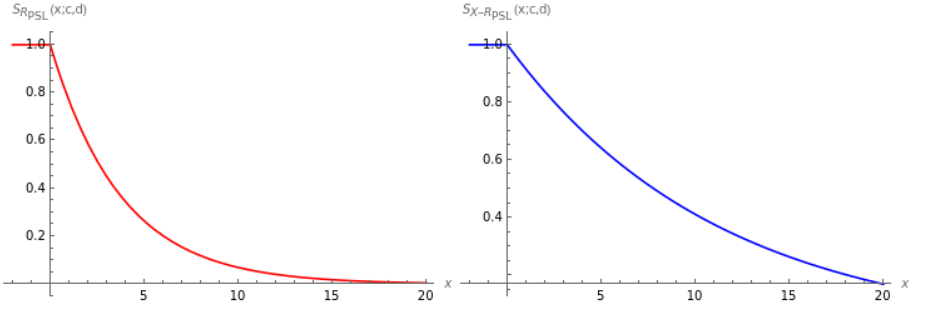
( x ; c , d ) and S ( x ; c , d ) X −R PSL ( X ) PSL ( X )